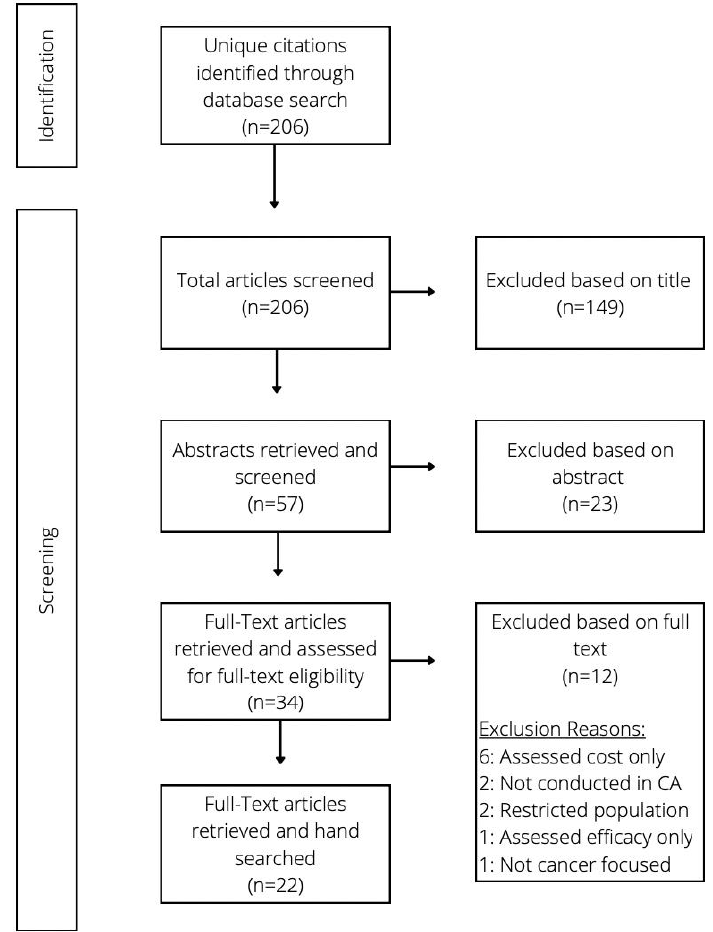
Figure 1. Flowchart of literature search and selection.